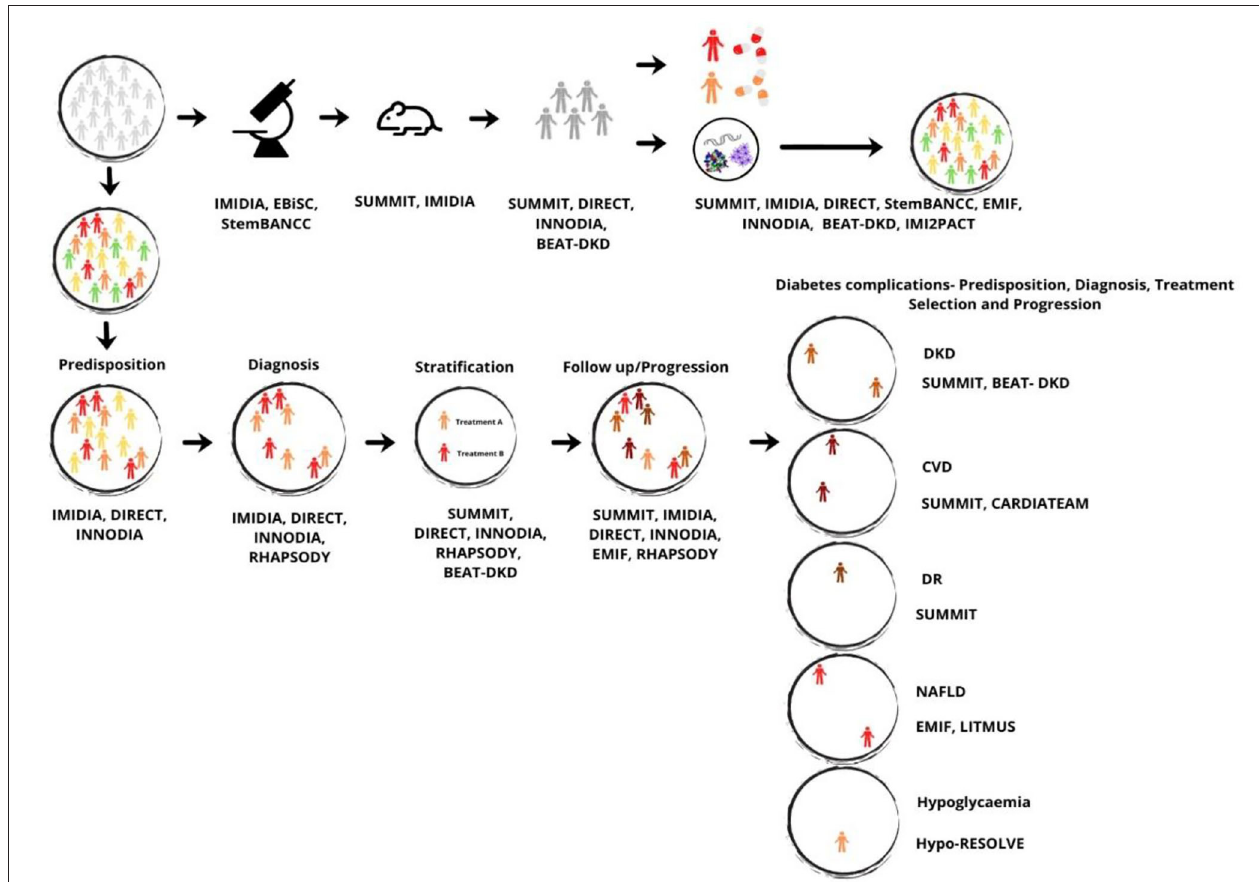
FIGURE 3 | Integrated vision model for diabetes, based on the objectives and results of the IMI funded-projects. Color meaning: gray, general population; green, individuals at low risk of diabetes; yellow, individuals at medium risk of diabetes; orange, individuals at medium-high risk of diabetes; red, individuals at high risk of diabetes; dark orange, individuals at high risk of DKD; dark red, individuals at high risk of CVD; brown, individuals at high risk of DR; light red, individuals at high risk of NAFLD; and light orange, individuals at high risk of hypoglycaemia. BEAT-DKD, Biomarker Enterprise to Attack DKD Project; CARDIATEAM, Cardiomyopathy in Type 2 Diabetes Mellitus Project; CVD, Cardiovascular diseases; DIRECT, Diabetes Research on Patient Stratification Project; DKD, Diabetic Kidney Disease; DR, Diabetic Retinopathy; EBiSC, European Bank for induced pluripotent Stem Cells Project; EMIF, European Medical Information Framework Project;